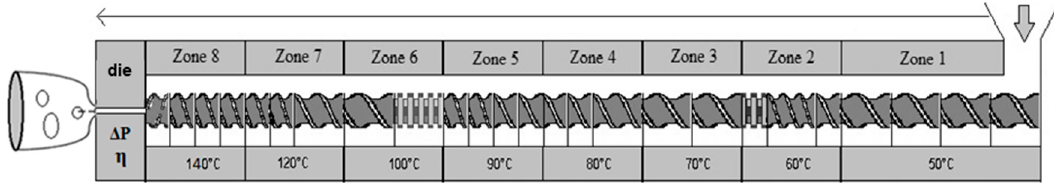
Figure 3. Configuration of the co-rotating twin-screw extruder machine.